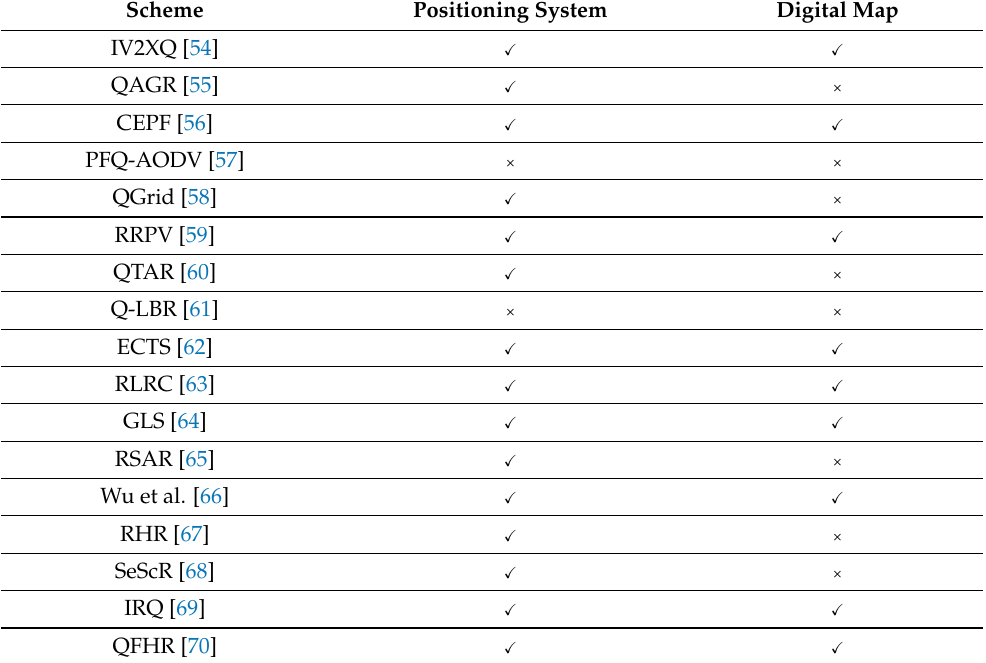
Table 10. Comparison of various routing methods in terms of positioning systems.